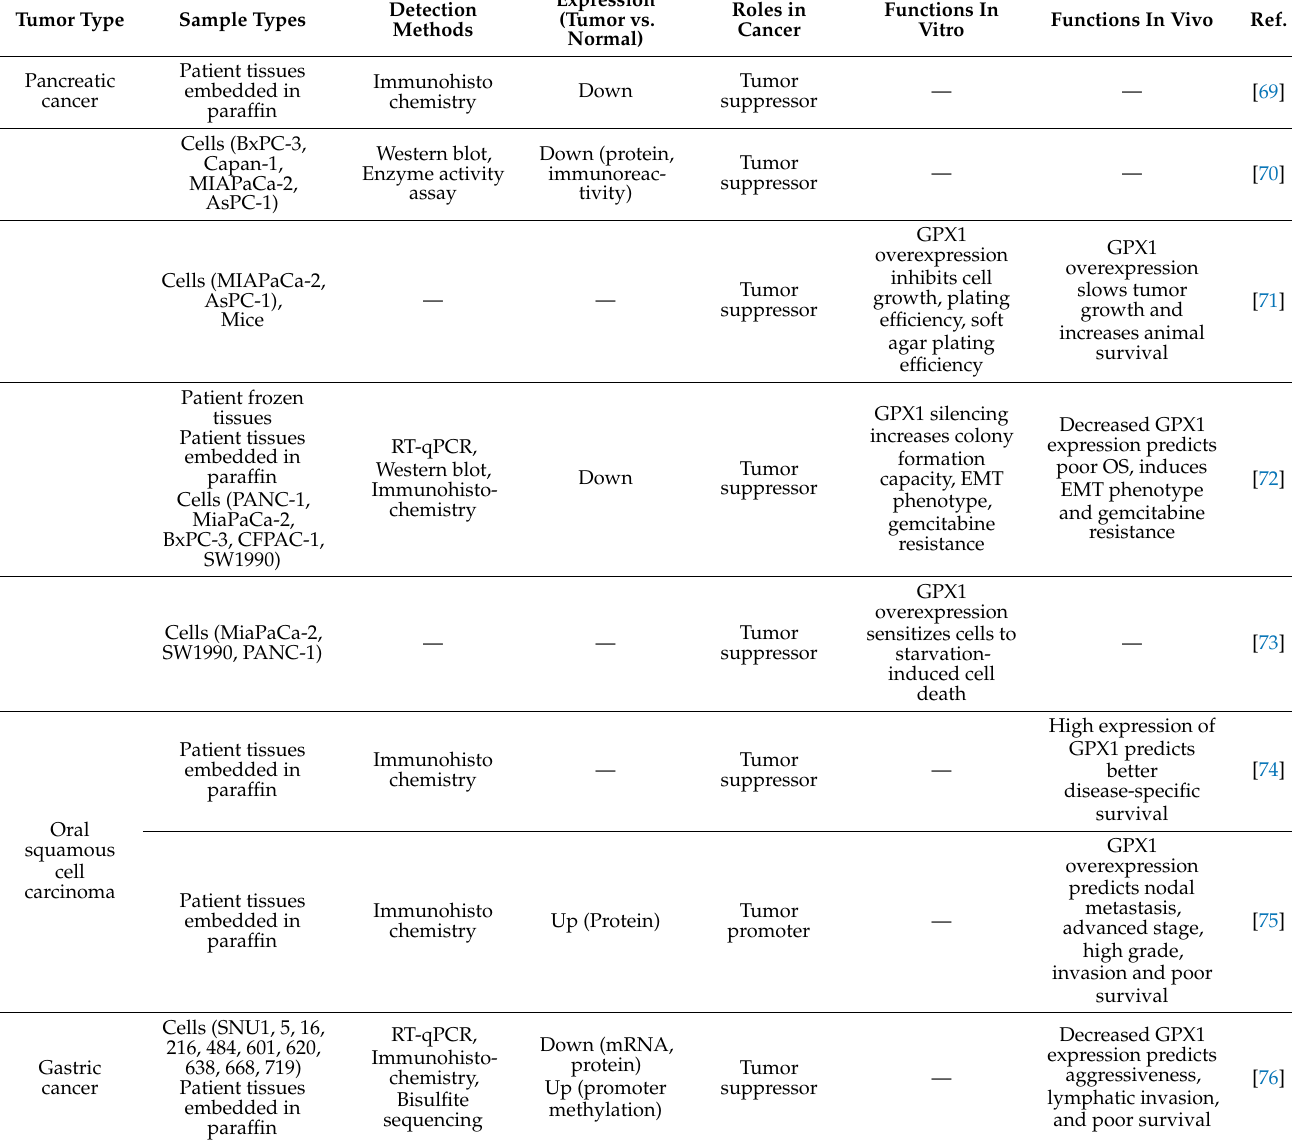
Table 2. Functional characterization of GPX1 in human